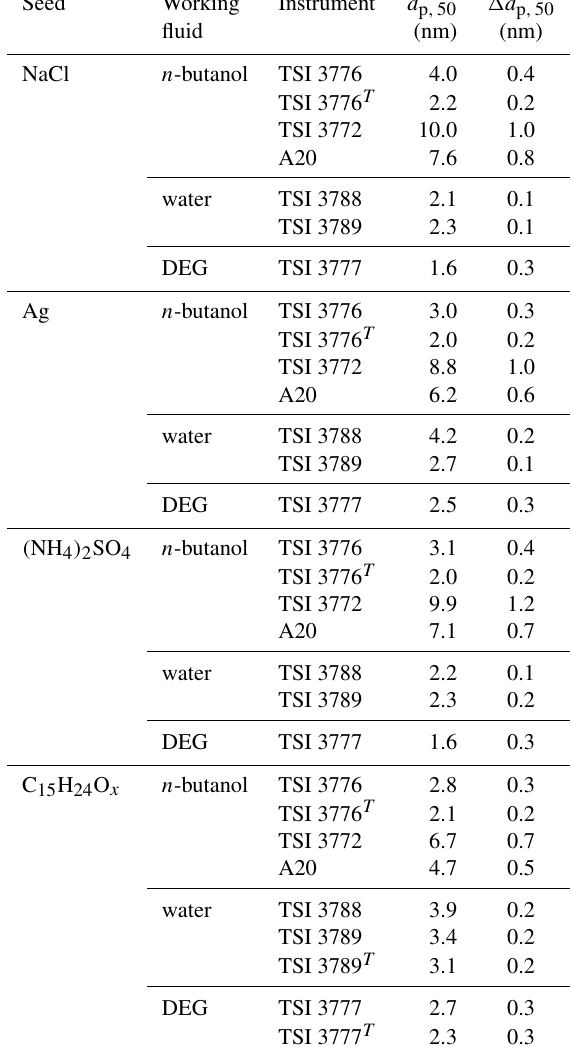
Table 3. Summarized 50% cutoff diameters: the table shows the measured 50% cutoff diameters for the four different seed particle materials and for every particle counter in